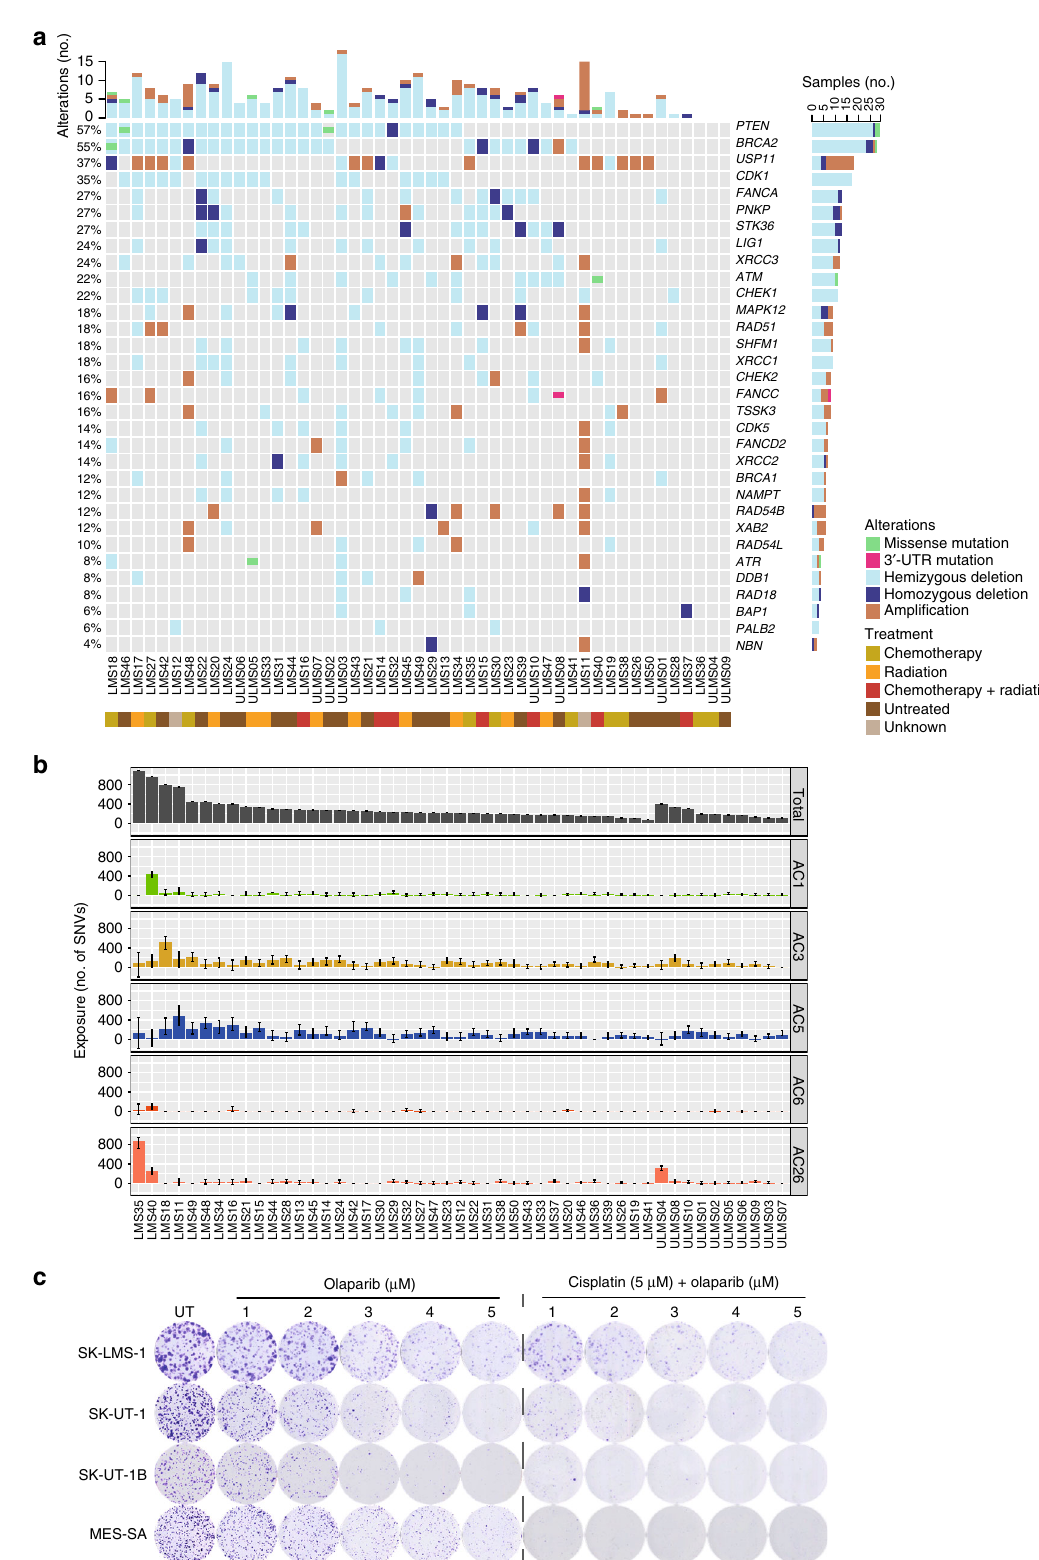
SNVs were also not allowed to overlap with any two of the following features at the same time: tandem repeats, simple repeats, low complexity, satellite repeats, or segmental duplications. After annotation with RefSeq (version September 2013)